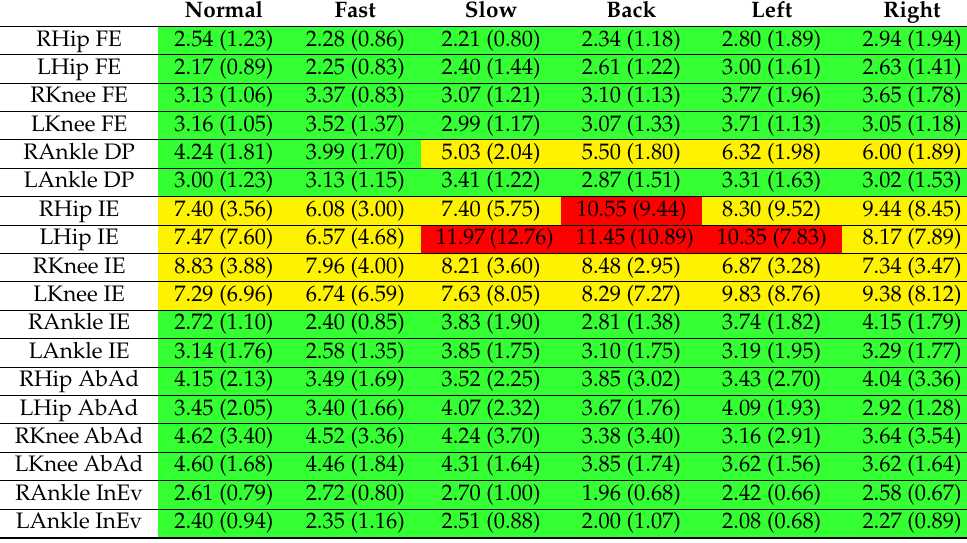
Table 2. Comparisons of joint angles with Cluster Method. Mean (Standard Deviation) of RMS difference (IMU-Clust) in estimates for each joint angle. All angles in degrees. Green, yellow, and red highlights indicate mean values <5 deg, <10 deg, and ≥ 10 deg, respectively. Results segmented by type of walking gait; namely normal forward (Normal), fast forward (Fast), slow forward (Slow), backward (Back), lateral left (Left), and lateral right (Right). Joint angles are flexion/extension (FE), internal/external rotation (IE), abduction/adduction (AbAd), dorsiflexion/plantarflexion (DP), and inversion/eversion (InEv). R and L prepended to joint names indicate right and left side, respectively. Normal Fast Slow Back